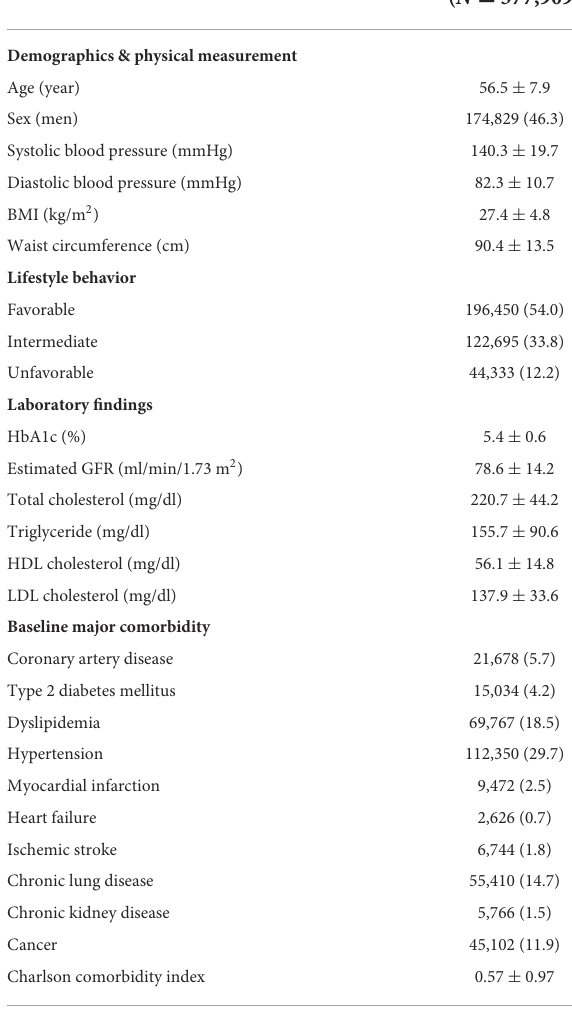
TABLE 1 Characteristics of participants at